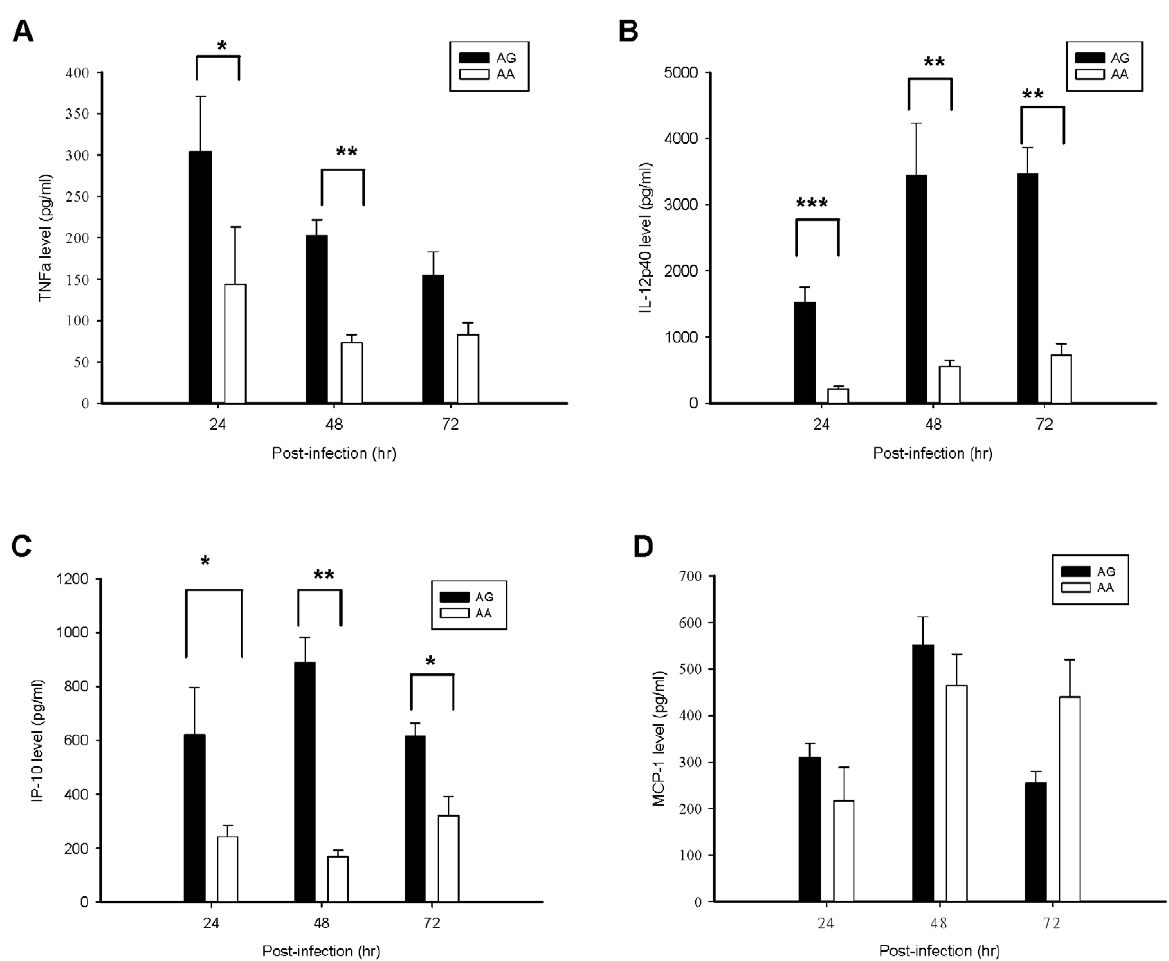
Figure 3. Kinetic cytokine/chemokine production by DEN-infected MDDCs from individuals with AA or AG genotype of rs4804803. The supernatant of TNF a , IL-12p40, IP-10 and MCP-1 levels were measured using ELISA after DEN infection at MOI of 5 for 24 to 72 h. The production of TNF a (A), IL-12p40 (B), and IP-10 (C) levels after DEN-2 infection was significantly higher in MDDCs from individuals with AG genotype than those with AA genotype. The production of MCP-1 (D) after DEN-2 infection was not significantly different between the two groups. The results are shown as mean 6 s.e.m. from subjects with AA (n=8) or AG (n=8) genotype in three independent experiments. Statistical values were determined by Mann-Whitney U test. Asterisk (*) indicates a significant difference ( p , 0.05). ** indicates p , 0.01; *** p , 0.001.